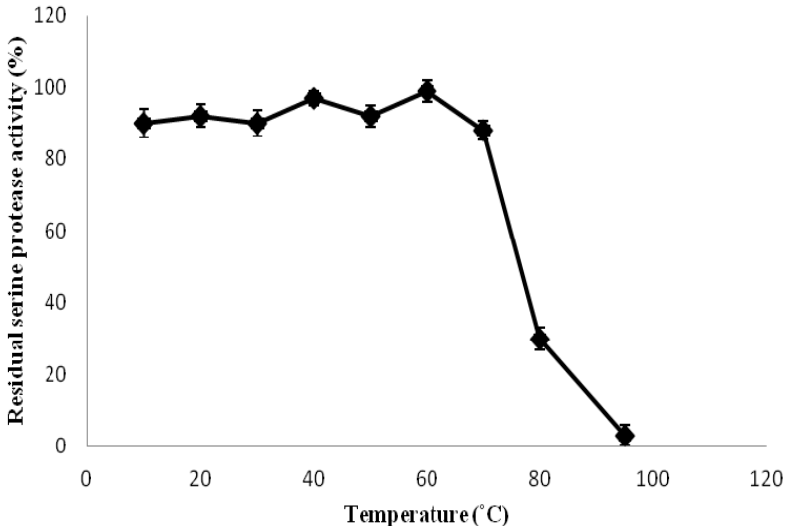
Figure 2. The influence of temperature on stability of kesinai serine